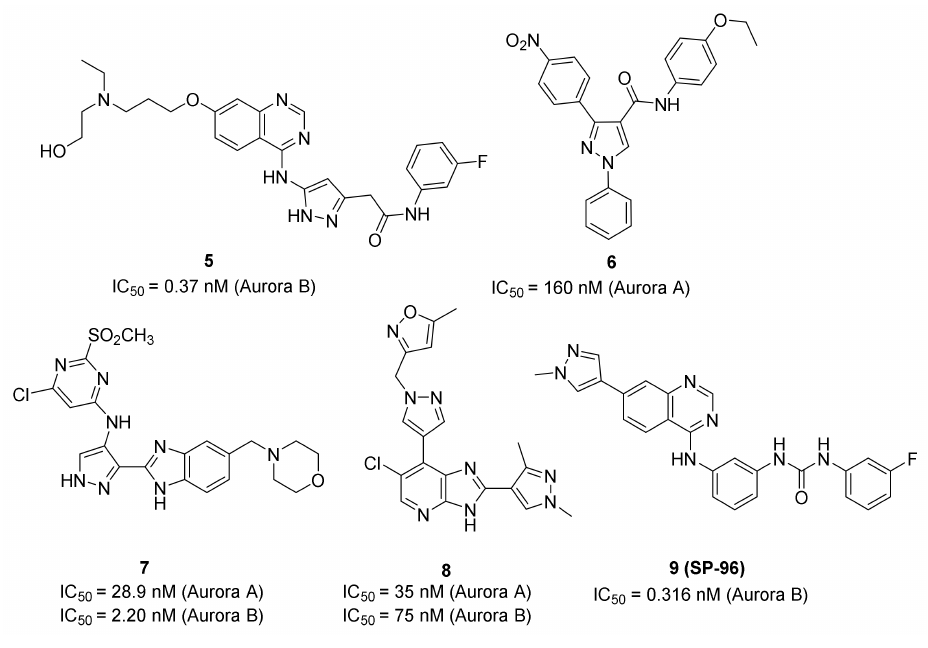
Figure 15. Structures of pyrazole-based Aurora kinase inhibitors and their IC 50 values.